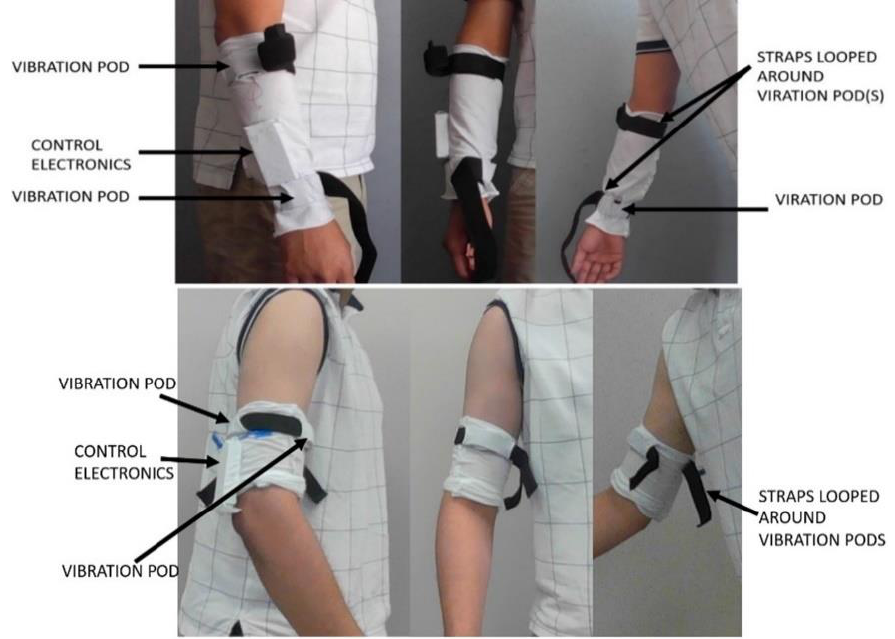
Figure 4. Top: Forearm sleeve with straps open. Embedded focal vibration pods and a control electronics box are labeled. These can be removed if the sleeve needs to be washed. Bottom: when the vibration pods and control electronics are attached to the upper arm with the sleeve.